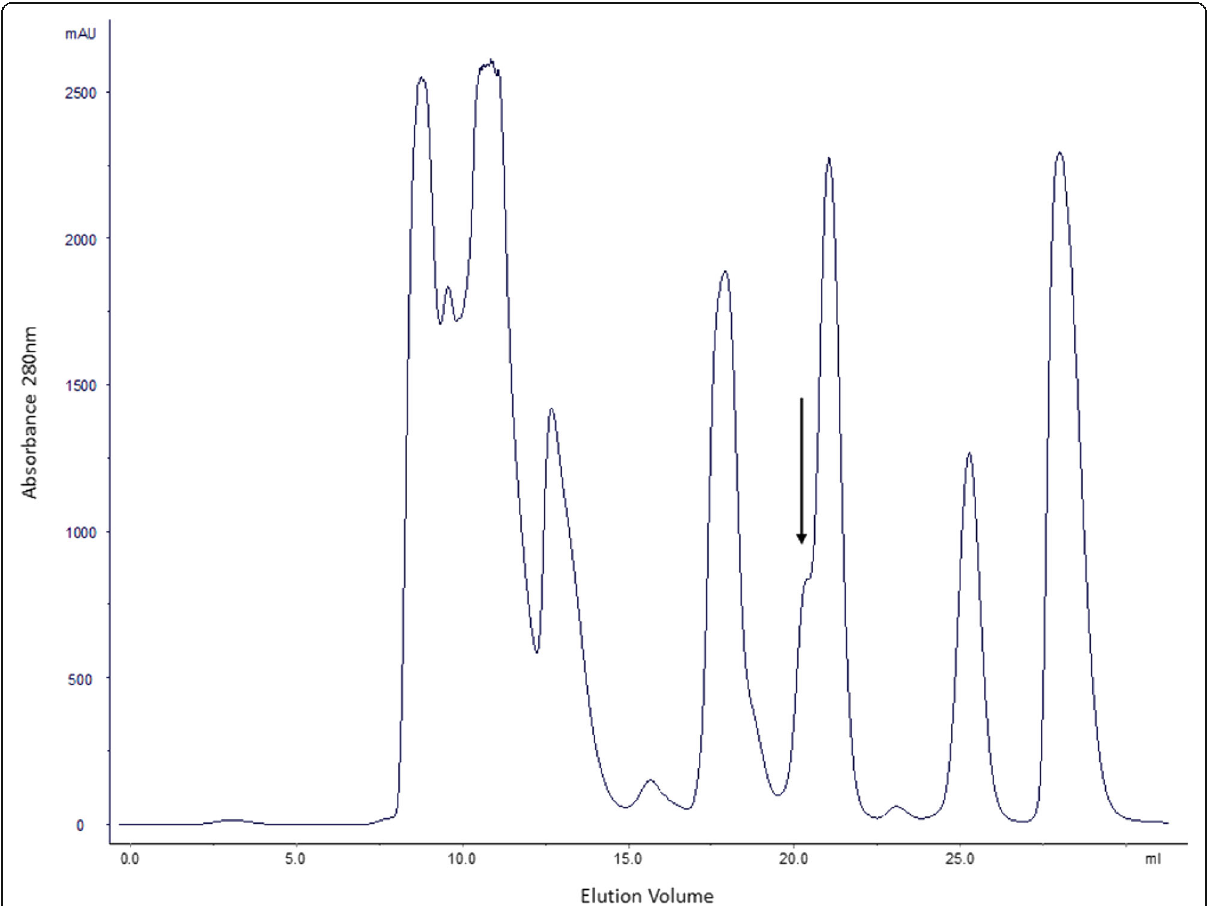
Fig. 1 Elution profile of 30 mg of B. g. rhinoceros venom on a Superdex 75 10/300 column. The flow rate was of 0.6 mL/min. The arrow indicates the fraction (peak 9) that was further